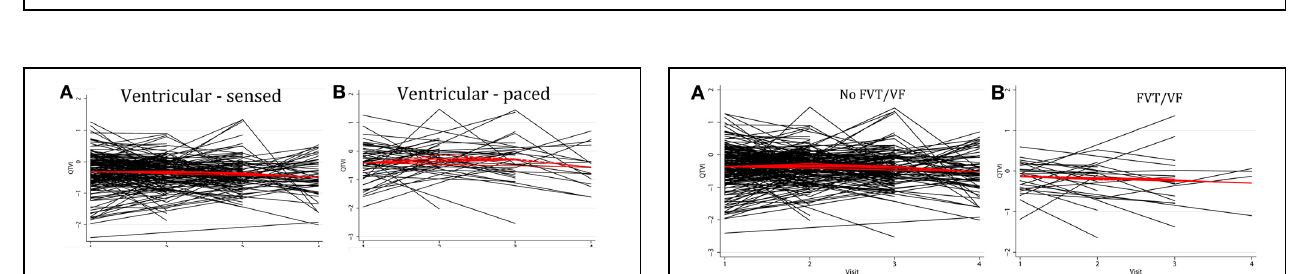
FIGURE 5 | “Spaghetti” plots of individual patient-specific longitudinal relationships between QTVI NF and time for each subject with (A) single-chamber ICD, (B) dual-chamber ICD, (C) CRT-D.